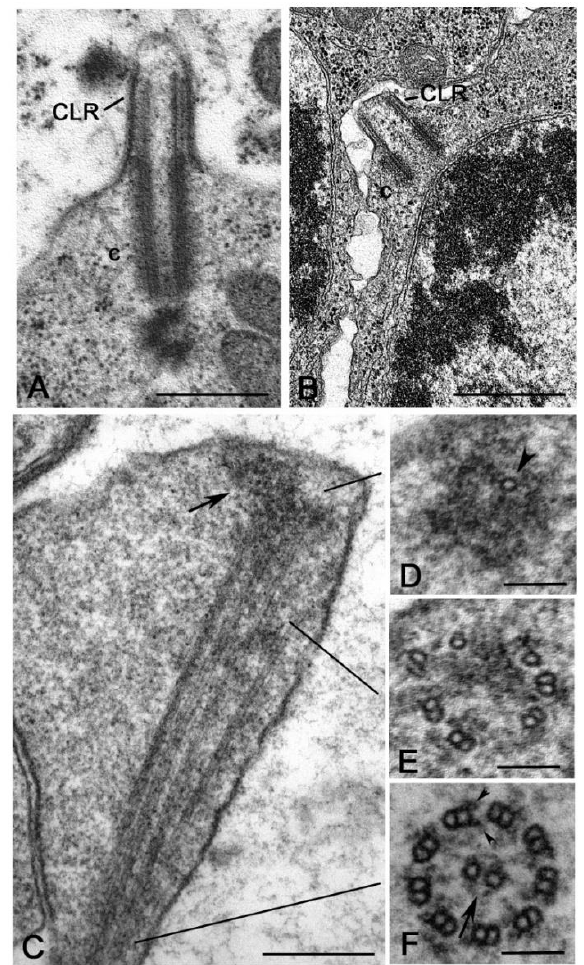
Figure 7. Ciliary projections in the male germ cells of Hexapoda. ( A ) Mature Drosophila primary spermatocytes showing full length centrioles (c) projecting out the plasma membrane to assemble a distinct cilium-like region (CLR). ( B ) Primary spermatocyte of Acerentomon with a short centriole ( C ) and CLR. ( C ) Longitudinal section of the distal enlarged region of a ciliary projection in the butterfly Pieris : note the apical cluster of electron-dense material (arrow) in which the tips of some microtubules end. ( D , E , F ) Cross sections of the ciliary projections showing the gradual organization of the axoneme from the apex to the basal region. ( D ) Distal sections show a few single tubules (arrowhead) within the electron-dense material. (E) Sections at a lower level display complete and incomplete doublet of microtubules. ( F ) Proximal sections show complete axonemes consisting of nine doublets of microtubules with dynein arms (arrowheads) and the central tubules (arrow). Bars: A,B, 500 nm; C, 250 nm; D–F, 100 nm.